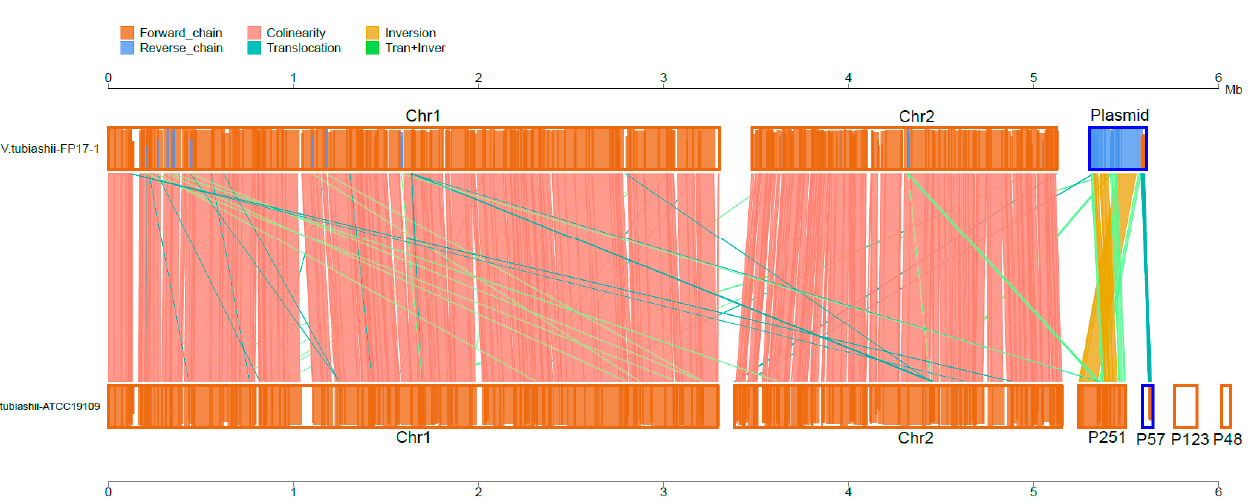
Table 2. Virulence factors of V. tubiashii FP17.